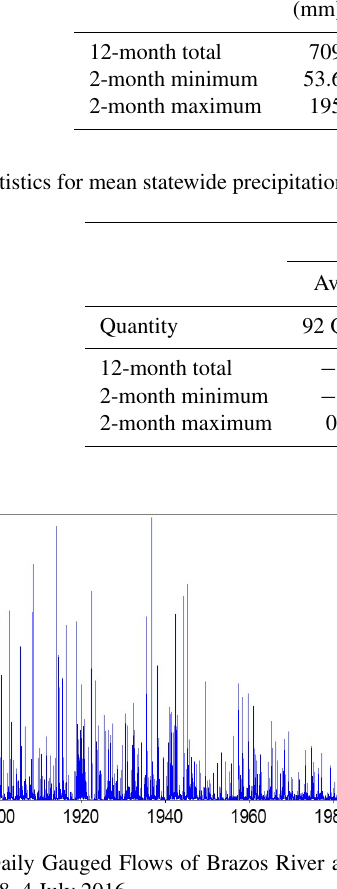
nual Minimum Monthly Flow (red dots) of the Brazos River at Rich-